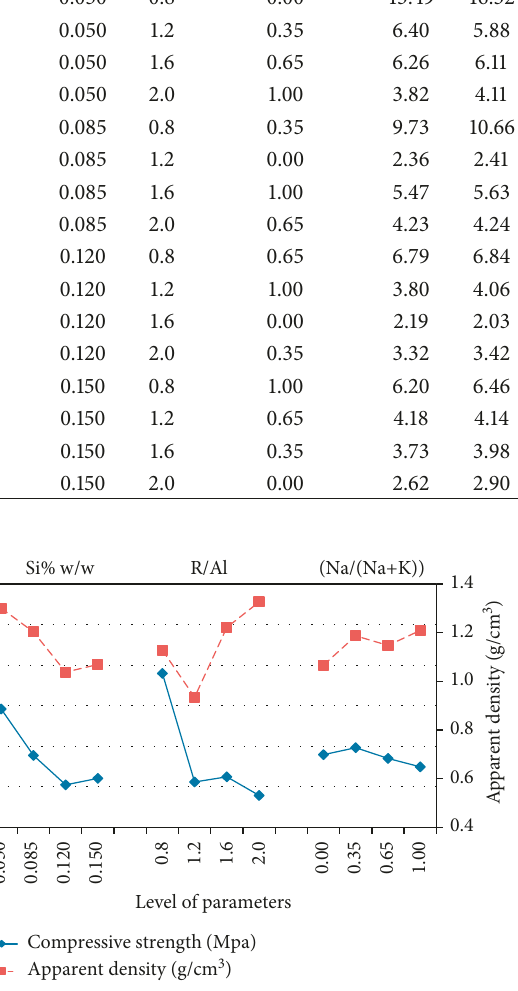
Table 3: Synthesis parameters, compressive strength, and apparent density of Si foamed geopolymers.